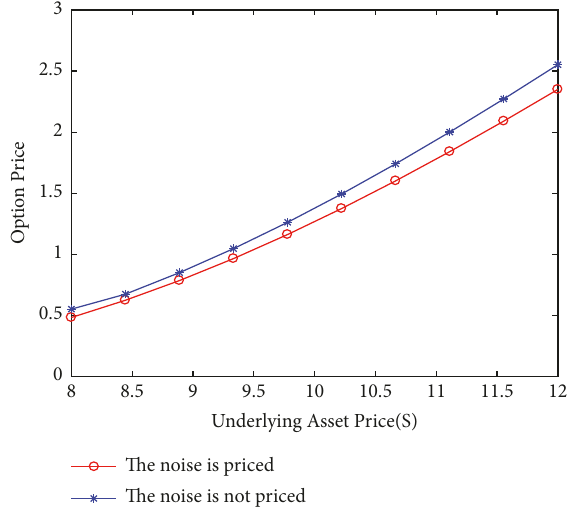
Figure 2: The influence of noise on vulnerable call option with incomplete